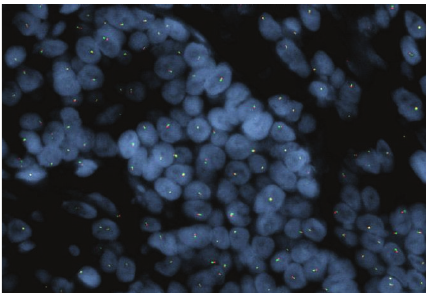
Figure 7: Dual color break-apart FISH probe with only one intact EWSR1 signal in majority of